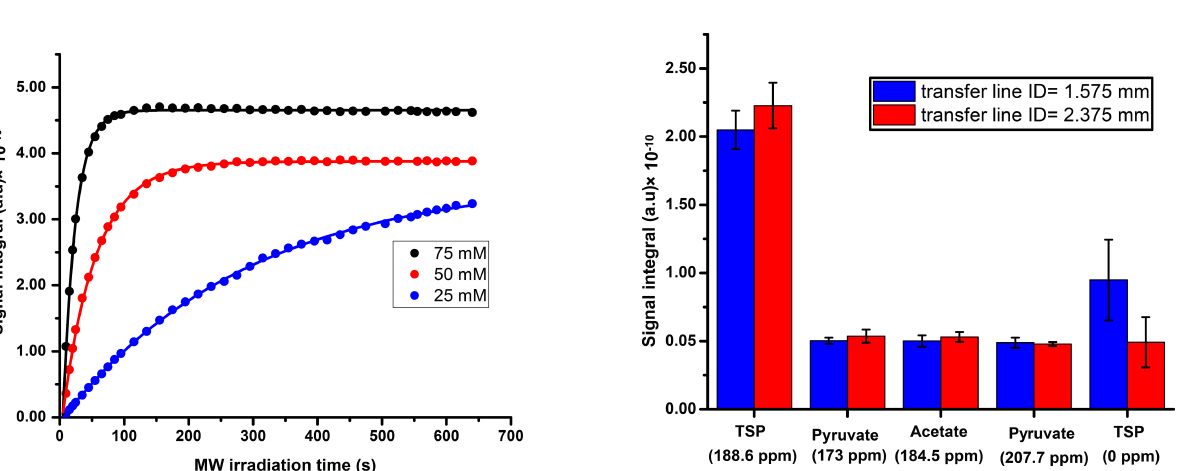
Figure C1. 1 H DNP polarization buildup plot at different TEM- POL concentrations (75, 50, and 25mM). The data points are fitted monoexponentially to obtain the DNP buildup rate.